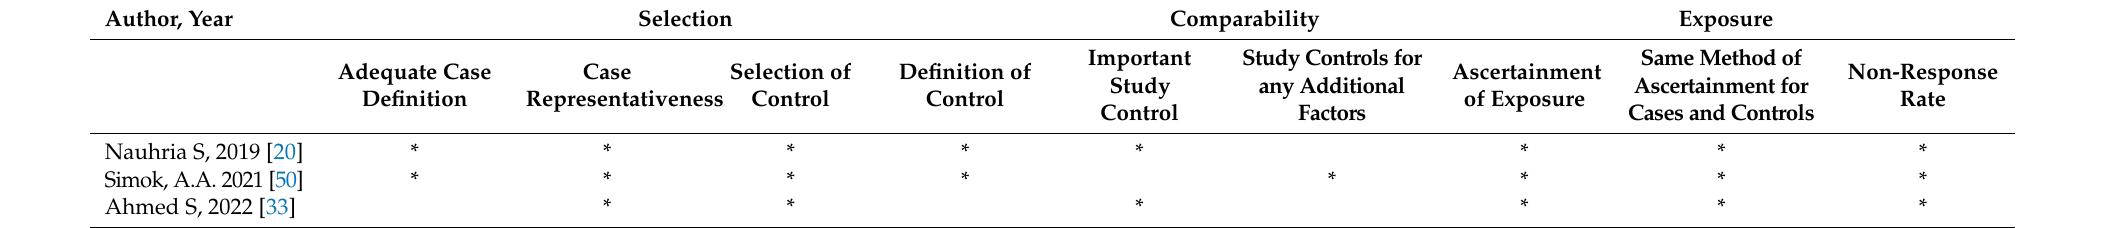
Table 4. The summary of quality assessment of randomized controlled studies using NOS scale.